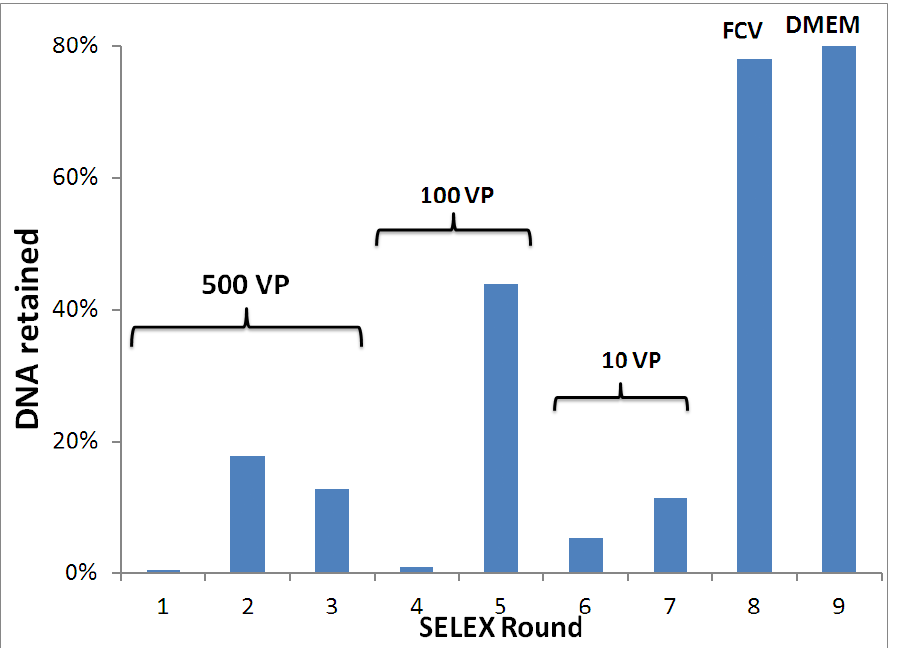
Figure 2. Summary of rounds for MNV SELEX. Target stringencies are outlined for sets of rounds (VP=viral particles). Retained fractions were assessed by fluorescence. DNA retained after counter-selection rounds (8 and 9) represents pool that did not interact with the indicated targets